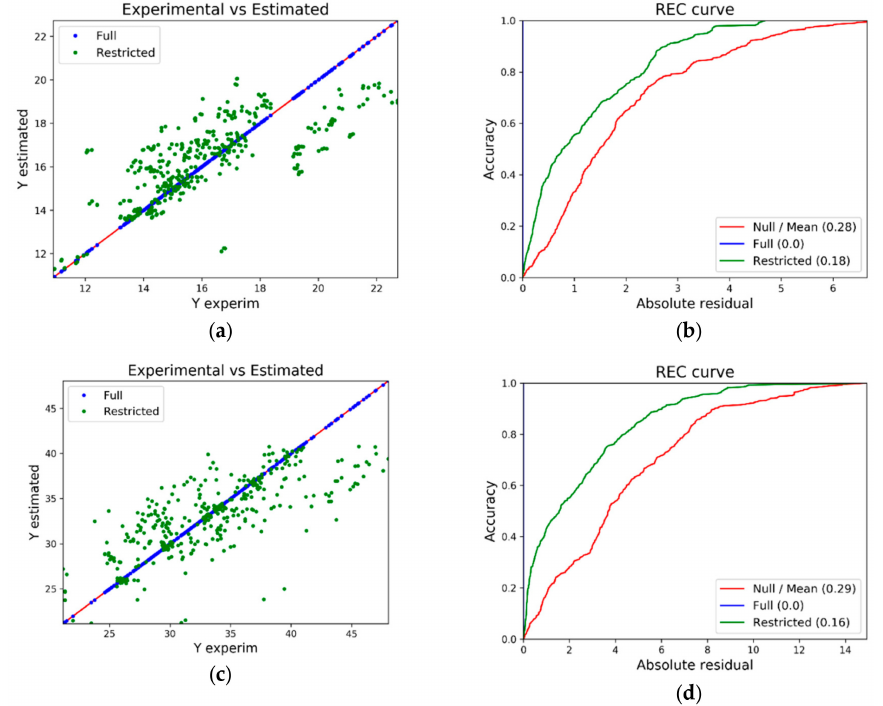
Figure 18. Results of the cooling load reduced problem for the full and restricted models with the parameter selection h = ω = 0.02. ( a ) Estimated vs experimental values for 1_floor model with five variables; ( b ) REC curve for the full, restricted and null (mean) 1_floor model; ( c ) Estimated vs experimental values for 2_floors model; ( d ) REC curve for the full, restricted, and null (mean) 2_floors model.